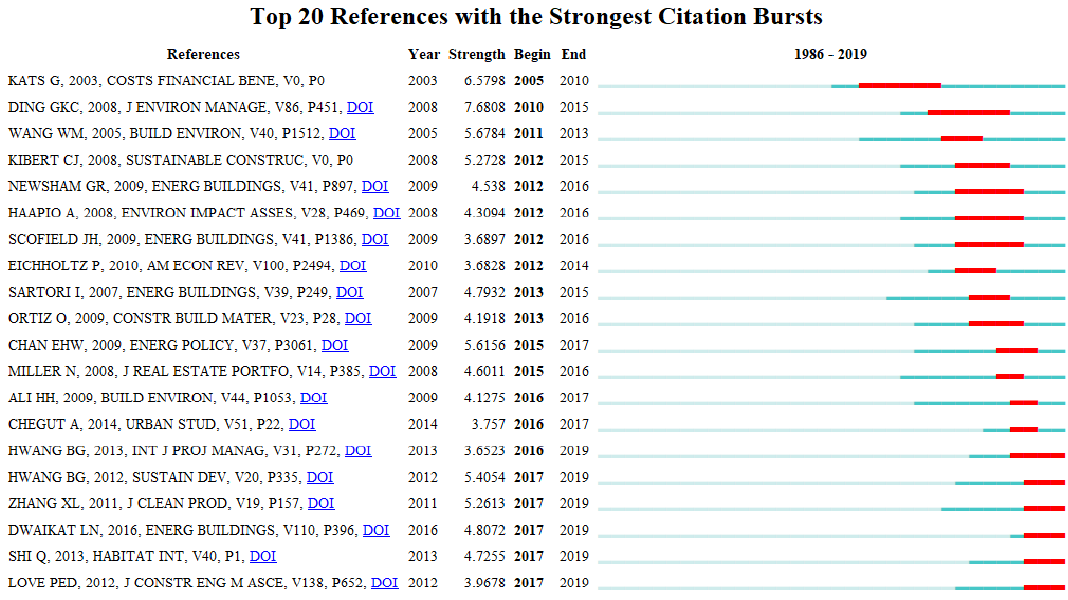
Figure 5. Top 20 reference with the strongest citation bursts.